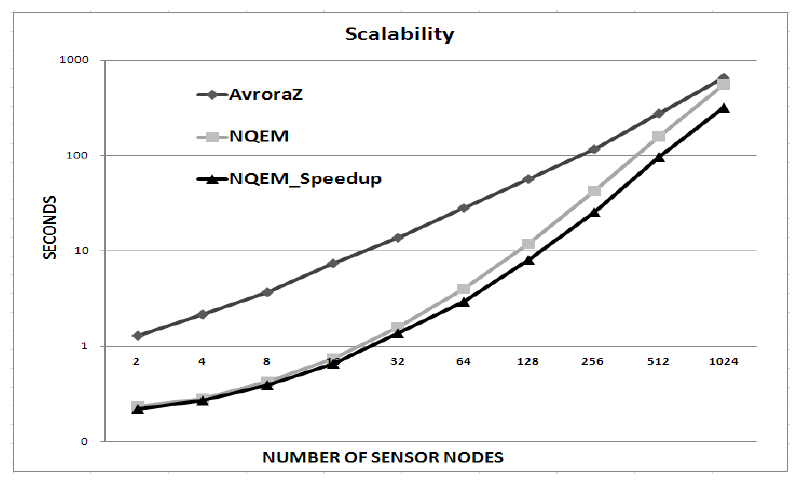
Figure 9. Scalability comparisons of NQEM and